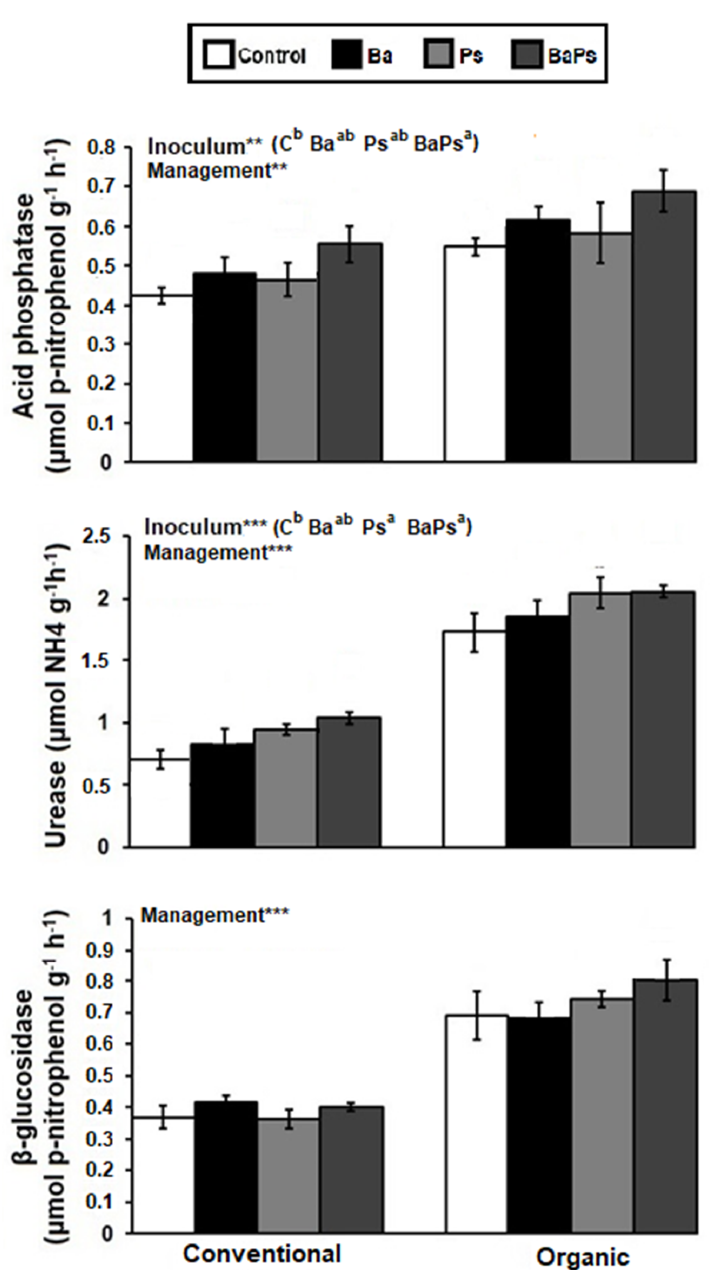
Figure 4. Mean values ( ± SE) of acid phosphatase, urease, and β -glucosidase enzymes in the conventionally and organically managed systems, at the four treatments. “Inoculum”, “Management” at the top of the graphs, indicate a significant e ff ect of these factors, as revealed by two-way ANOVA (**: p < 0.01, ***: p < 0.001, for all cases n = 4). Superscript letters in parentheses following the term “Inoculum” denote the significant di ff erences between inoculum types (C: Control, Ba: B. subtilis , Ps: P. fluorescens and BaPs: B. subtilis and P. fluorescens ) as emerged from Fisher’s test (Fisher post hoc; a: Corresponds to the highest